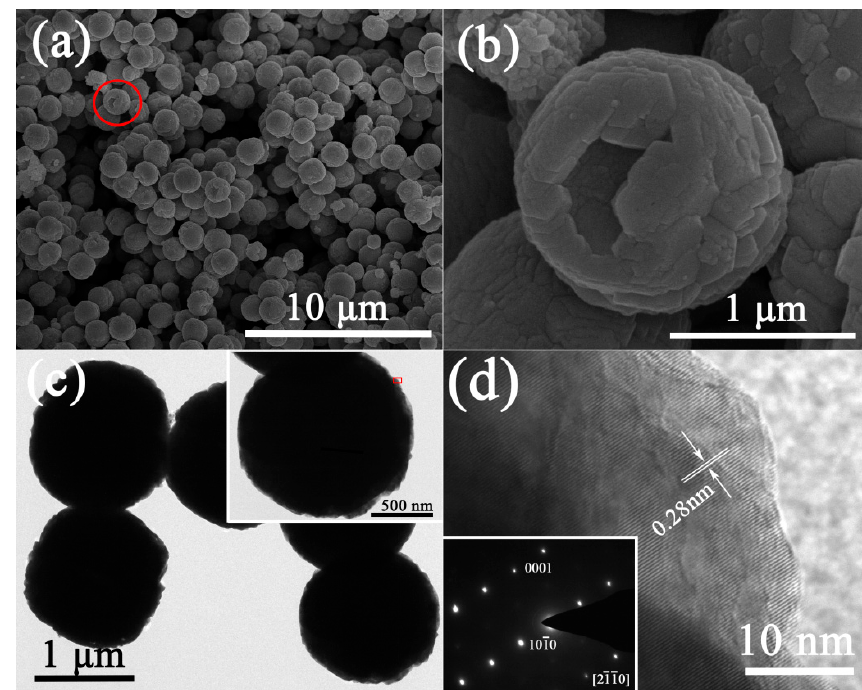
Figure 1. ( a , b ) SEM, ( c ) TEM, and ( d ) HR-TEM images of ZnO microspheres. The inset of ( d ) was the SAED pattern of the ZnO microspheres.